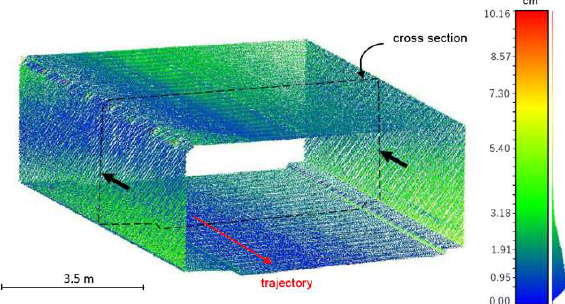
Figure 16: Differences between Puck-VUX point clouds in a tunnel.